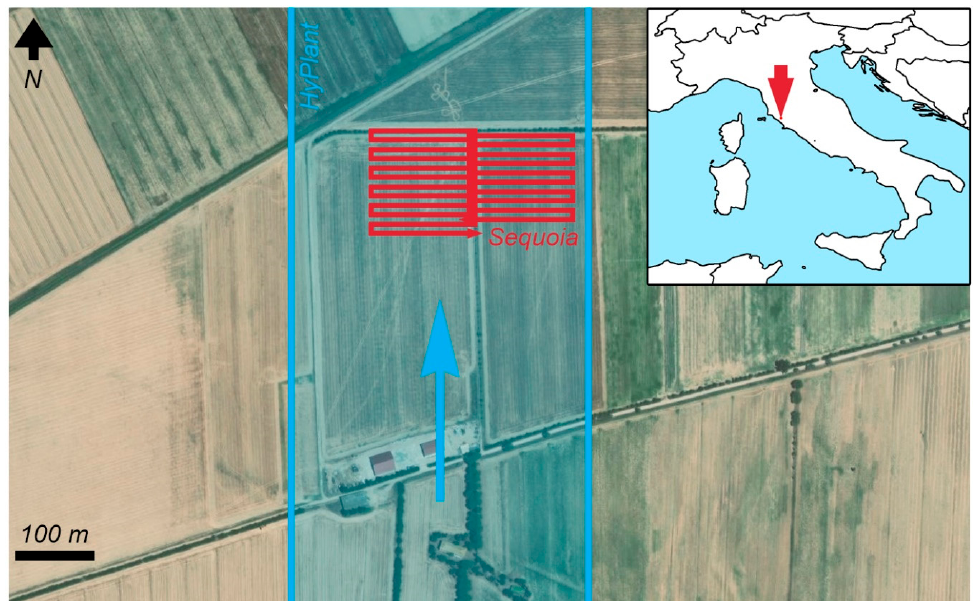
Figure 2. The studied maize field in the province of Grosseto, Italy is depicted along with its location (inset map). The flight lines and coverage of the drone (Sequoia, red) and airborne (HyPlant, blue) datasets are also shown. Image data licensed by ESRI, © DigitalGlobe.